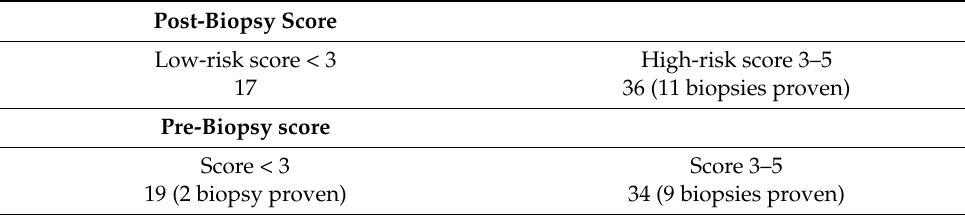
Table 4. ACR scores (n =